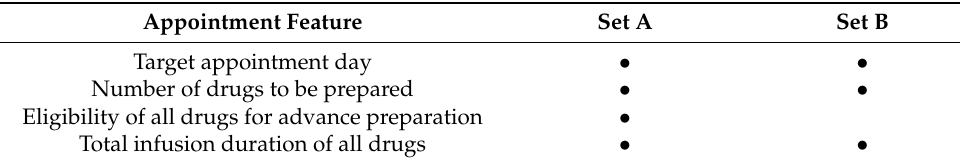
Table 5. The included appointment features in the sets of features A and